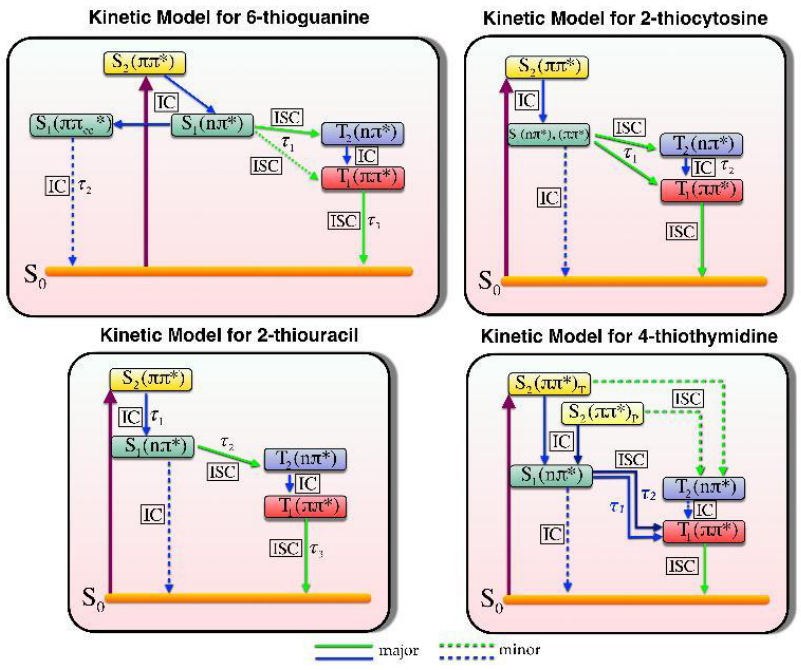
Figure 3. Proposed kinetic models for nucleobase thioderivatives inferred from the literature.